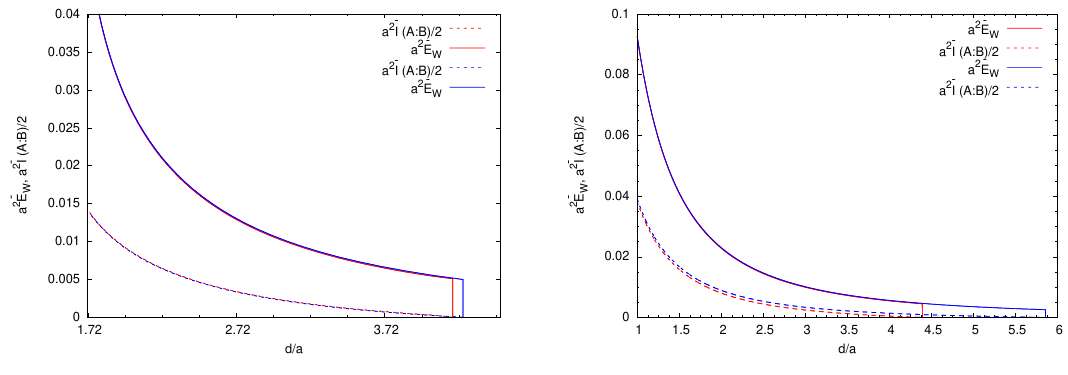
Figure 5 . Effect of noncommutativity on EWCS and HMI (we have chosen two values for l l = 6 (red) and l = 8 (blue)). The curve in the left panel depicts the analytical result in a a eq. (5.8), (5.9) (for au t ≤ 1 ) with au b = 10 . The curve in the right panel depicts the analytical results in eqs. (5.10), (5.11) (deep IR